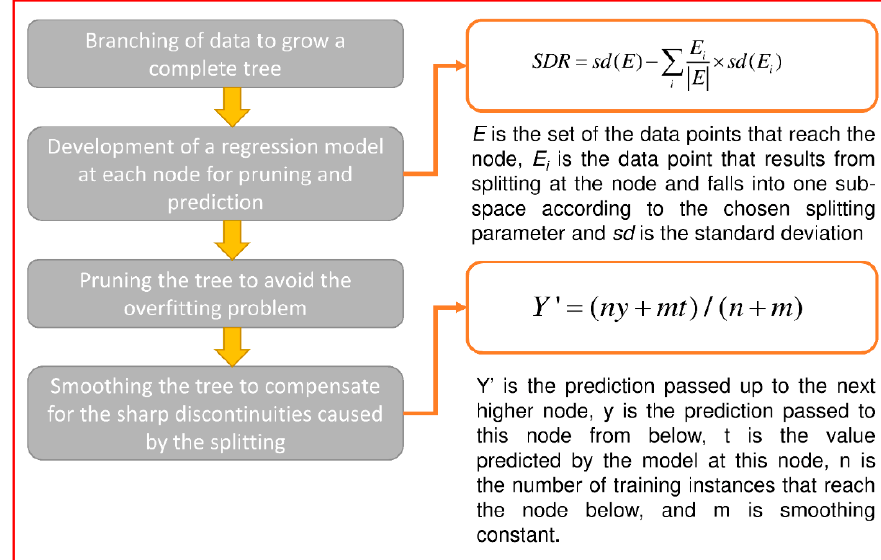
Figure 3. Cubist model and its operation for estimating ilmenite component.